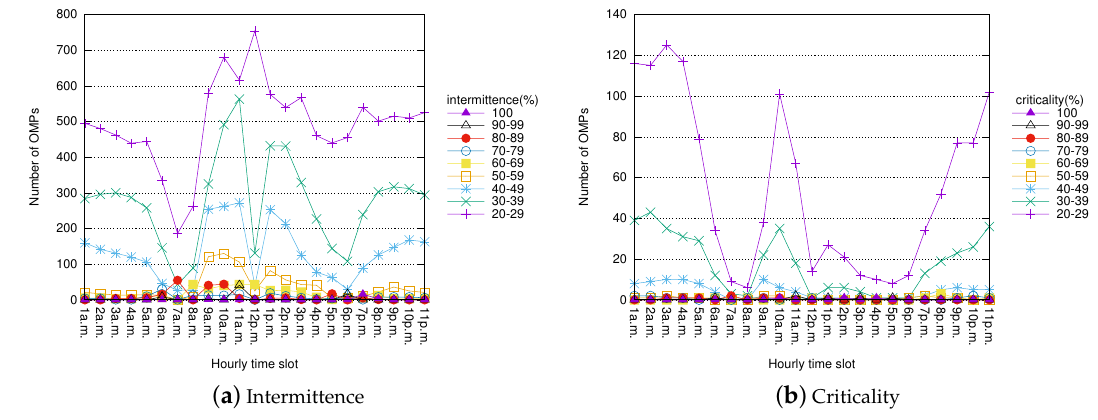
Figure 5. Citi Bike (New York). Hourly distribution of the number of OMPs and their corresponding levels of intermittence and criticality. maxdist = 0.5 km. time slot size = 1 h. full-th =